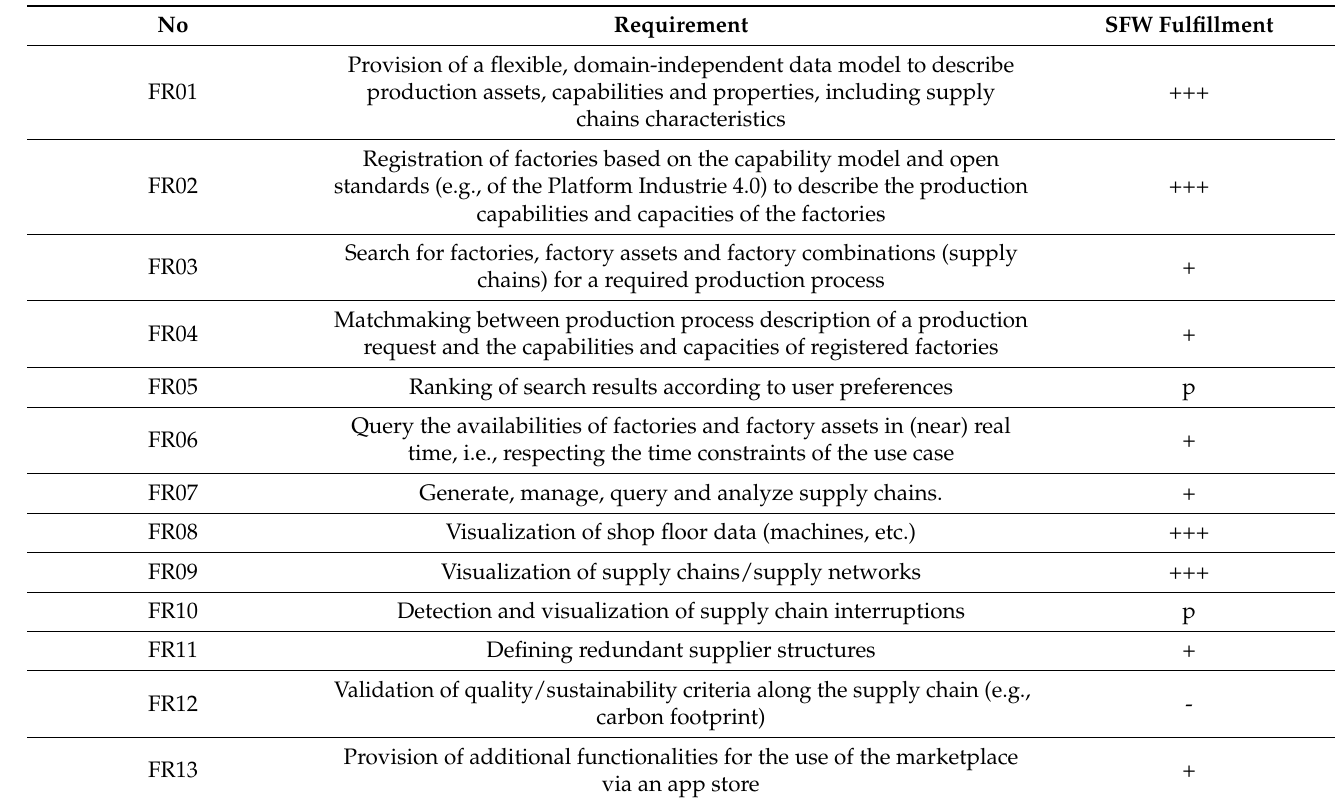
Table 8. Smart Factory Web in relation to the functional requirements in the platform